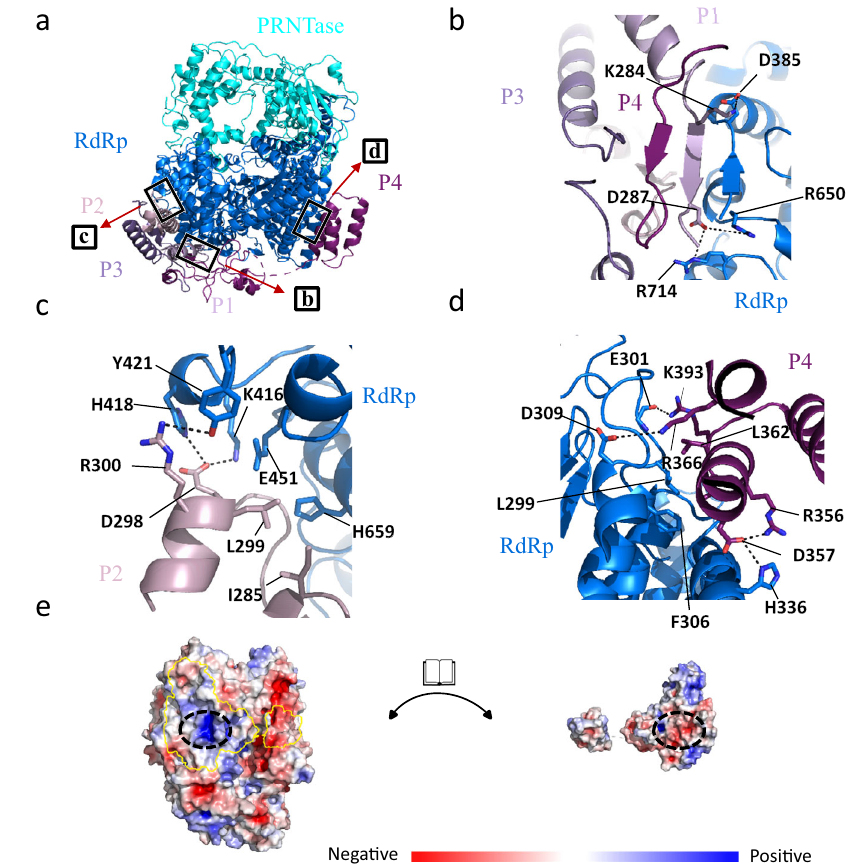
Fig.5|DetailsofthemolecularinteractionsbetweenNDVLandPproteins.a A cartoonrepresentationofNDVL-Pcomplexstructure.Theblackboxesindicatethe magni fi ed view of the interactions between L and P. b – d Magni fi ed views of interaction interfaces between L and P proteins. The representative residues involved in interaction are shown, main chain or side chains involved in hydrogen bonds or hydrophobic interactions are shown as sticks, with oxygen and nitrogen